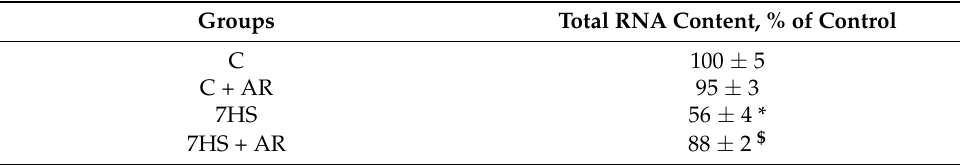
Table 3. Total RNA content in rat soleus muscle normalized per mg of muscle tissue. Groups